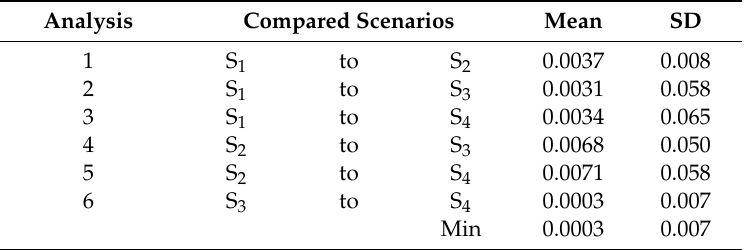
Table 6. Scenarios’ sensitivity analyses results.